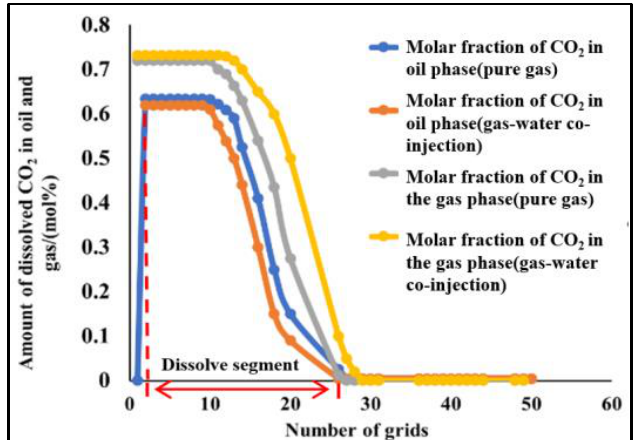
Figure 18. Molar fraction of CO 2 in oil and gas.